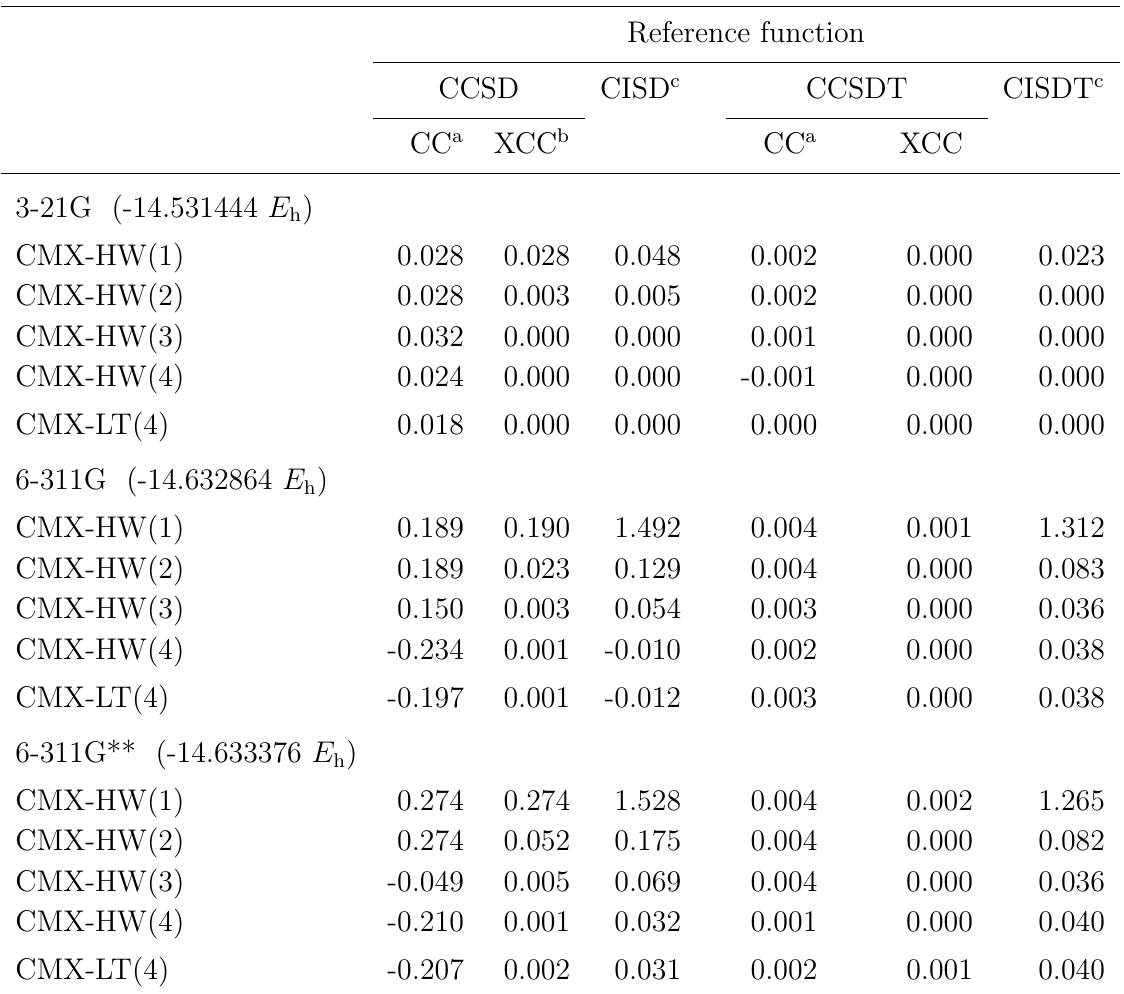
Table 1: Deviations of the CMX energies (in m E h ) from the full CI energies (in parenthesis) for beryllium atom with different basis